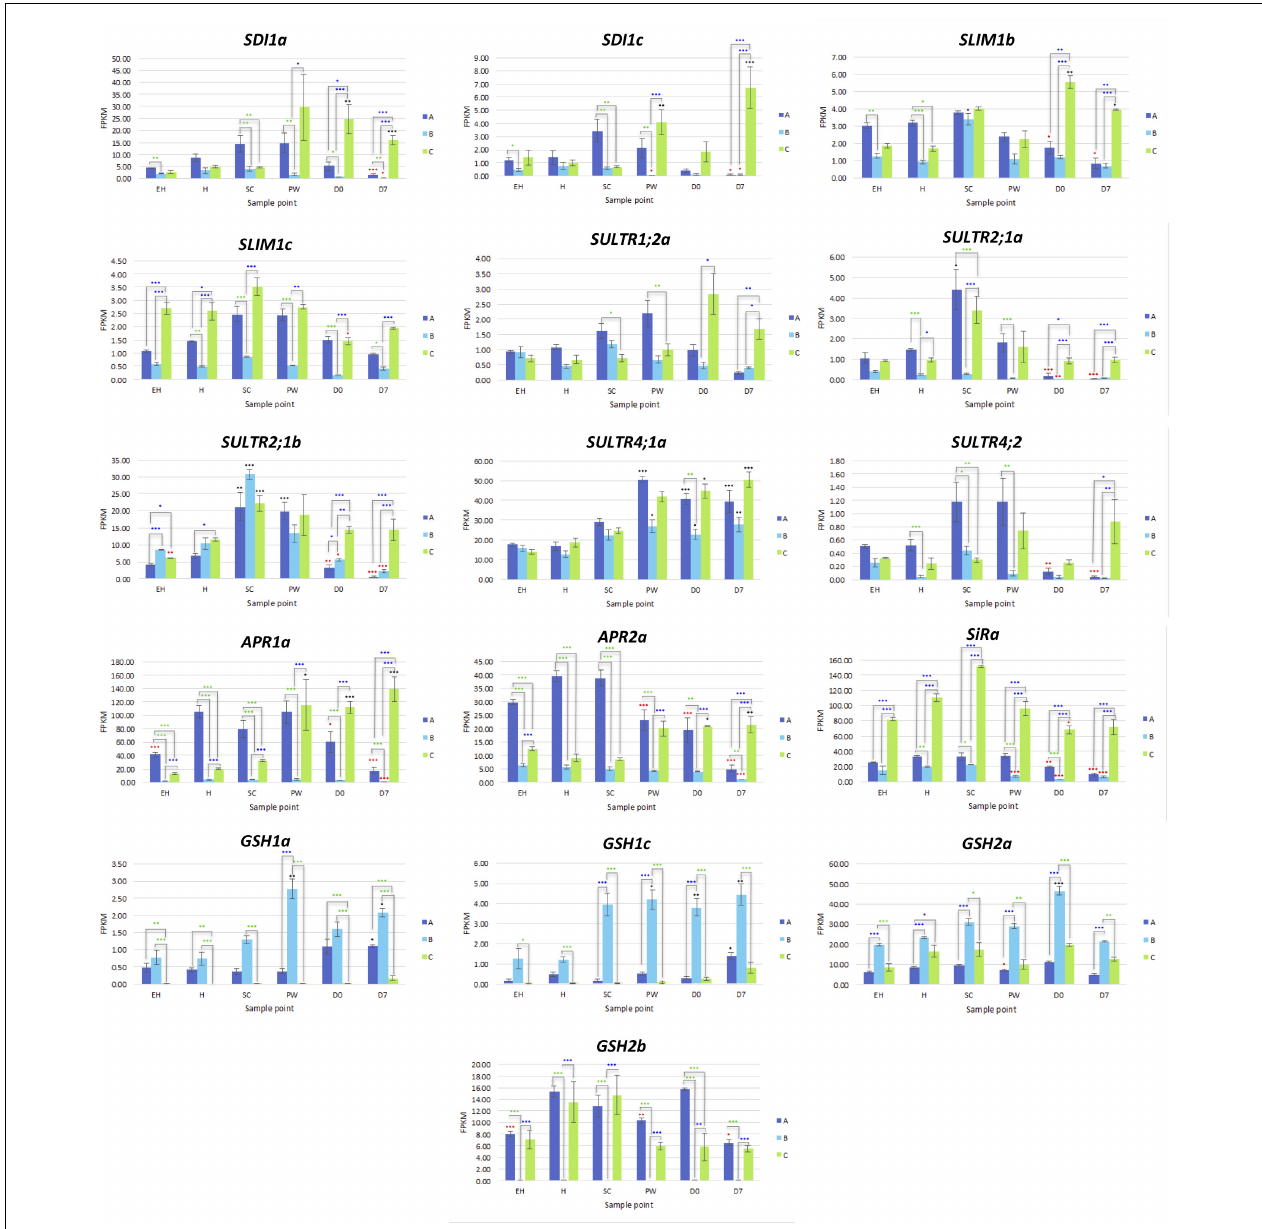
FIGURE 6 | RNAseq expression data (FPKM) for genes involved with sulfate transport and redox response in three elite inbred lines of Eruca sativa ( A , dark blue; B , light blue; C , green). Standard errors of the mean expression values are represented by error bars. Asterisks denote levels of significance of up and down regulation within sample points (between each inbred line) and relative to the point of harvest for each respective sample point: * p ≤ 0.05; ** p ≤ 0.01; *** p ≤ 0.001; green, significant up regulation between lines A , B , and C ; blue, significant down regulation between lines A , B , and C ; black, significant up regulation relative to H ; red, significant down regulation relative to H . EH , early harvest; H , harvest; SC , second harvest; PW , pre-wash; D0 , post-wash; and D7 , 7-day shelf